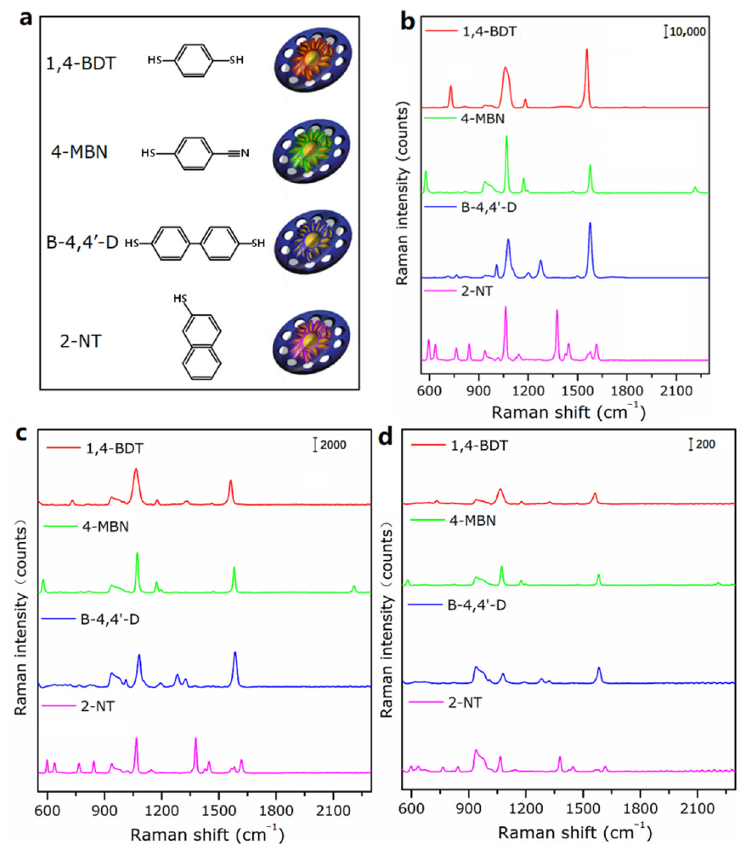
Figure 11. ( a ) Schematics; ( b ) Raman spectra of MS-GP-GERTs with different Raman reporters of 1,4-BDT (red), 4-MBN (green), B-4,4 ′ -D (blue), and 2-NT (purple) immobilized in the nanogaps; ( c ) Raman spectra of MS-GP-GERTs (10 pM) with different Raman reporters; ( d ) Raman spectra of MS-GP-GERTs (100 fM) with different Raman reporters.